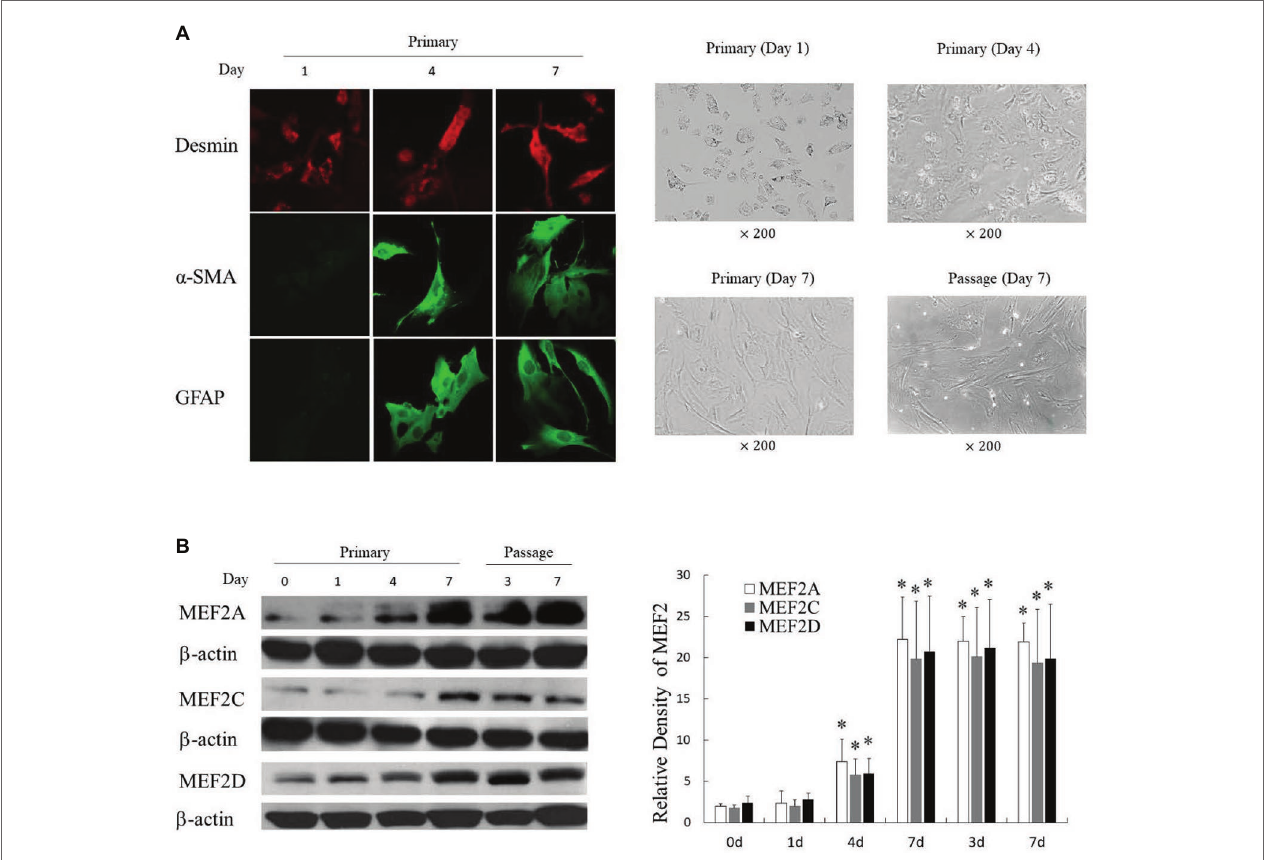
FIGURE 1 | Induction of MEF2 expression during culture-induced activation of primary H-HSCs. (A) Expression of activation markers in cultured H-HSCs. The left panel was determined by immunofluorescence. The right panel shows the morphology of H-HSCs under a phase contrast microscope. ‘Day’ indicates the number of days in culture. (B) Expression of the MEF2 protein in cultured H-HSCs. The levels of MEF2A, MEF2C, and MEF2D proteins were determined by western blot using isoform-specific antibodies. The right panel shows densitometry values of MEF2 proteins relative to β -actin. Each value represents the mean ± SEM ( n = 3, * p < 0.05 vs.